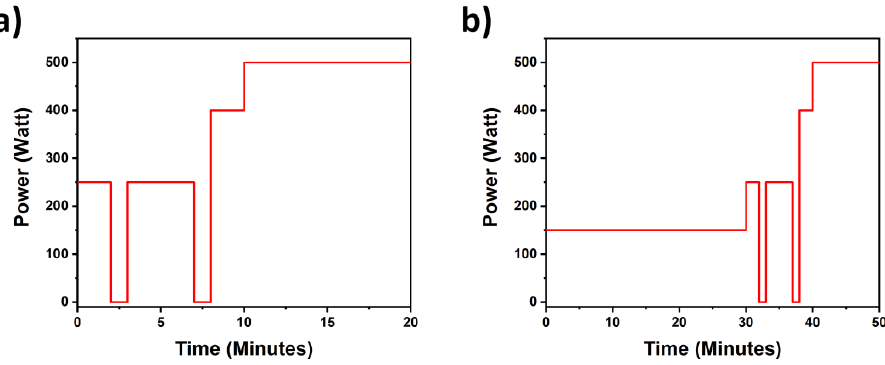
Figure 2. Microwave power programs used for ( a ) HF evaporation and ( b ) soil digestion.